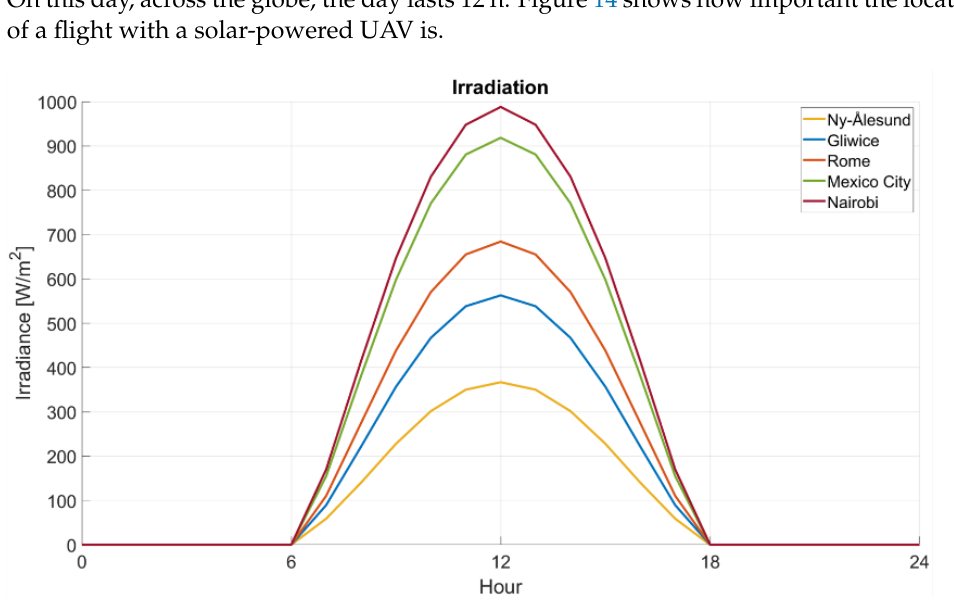
Figure 15. Irradiation for Gliwice in vernal equinox for different altitude.